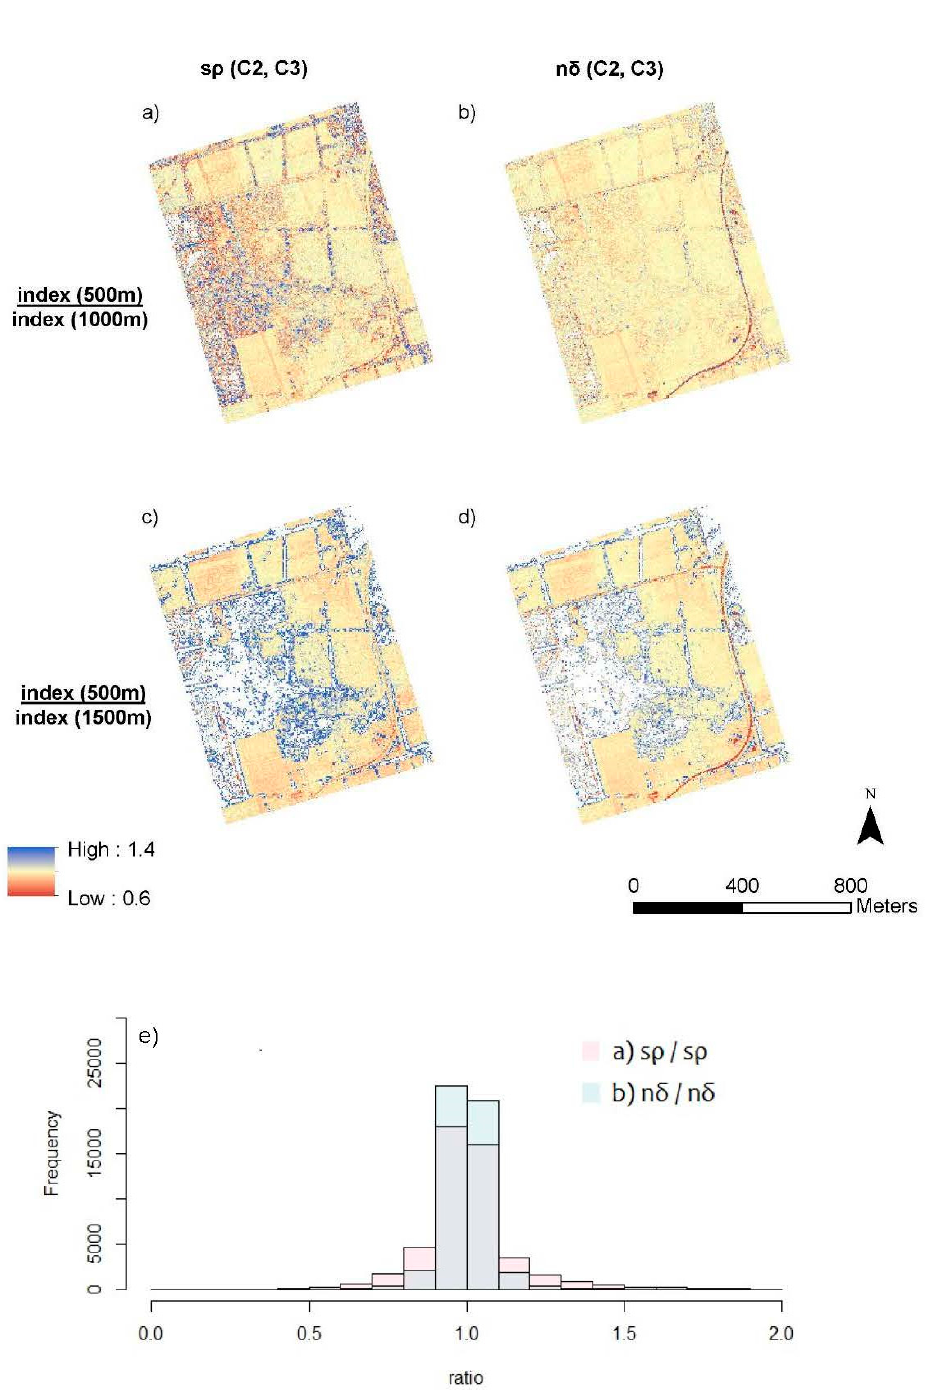
Figure 9. Ratios derived from single return indices at 4 m × 4 m grid: ( a ) ratio of s ρ (C2, C3) at 500 m to s ρ (C2, C3) at 1000 m; ( b ) ratio of n δ (C2, C3) at 500 m to n δ (C2, C3) at 1000 m; ( c ) Ratios of s ρ (C2, C3) at 500 m to s ρ (C2, C3) at 1500 m; ( d ) ratio of n δ (C2, C3) at 500 m to n δ (C2, C3) at 1500 m. ( e ) histograms for Figure 9a,b. White pixels represent no data.